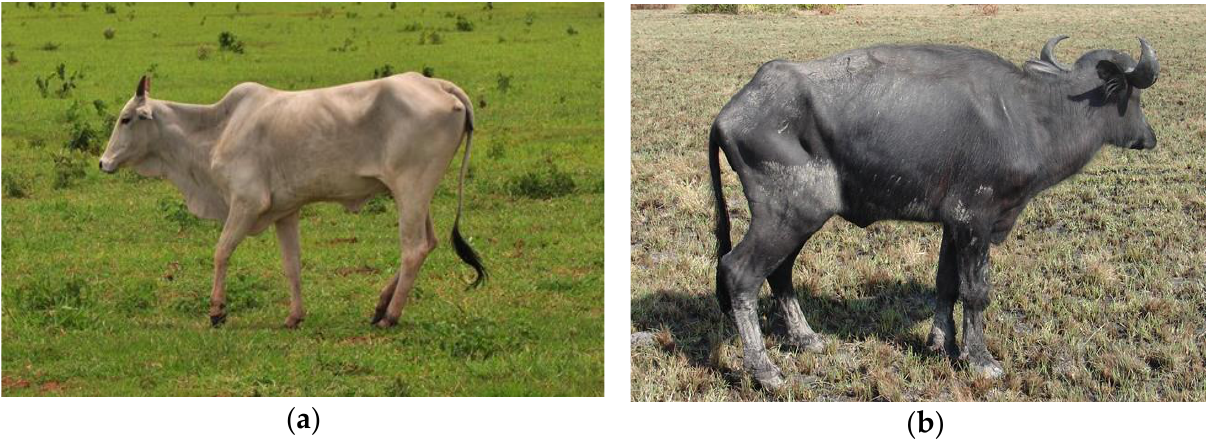
Figure 4. ( a ) Clinically P-deficient Nellore cow with stiff gait [11]. ( b ) Buffalo cow with “peg - leg” and arched back (kyphosis) [11].